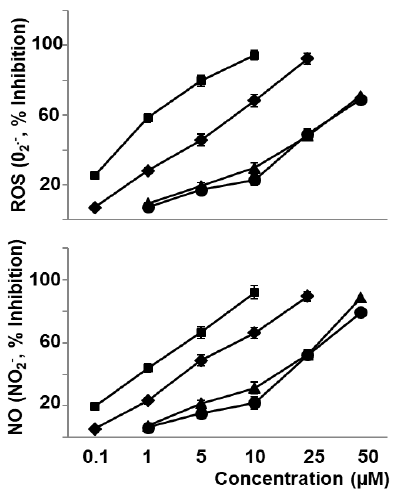
Figure 1. Effect of bioactive compounds of sofrito on O 2-. and NO 2- production stimulated by oxLDL. Macrophages were incubated with naringenin ( ♦ ), hydroxytyrosol ( ■ ), lycopene ( ▲ ), or β-carotene (●) for 30 min, and then stimulated with oxLDL (50 µg protein/ml) for 30 min. Finally, O 2-. and NO 2- were measured. Data are the means ± SEM of three experiments performed in triplicate.